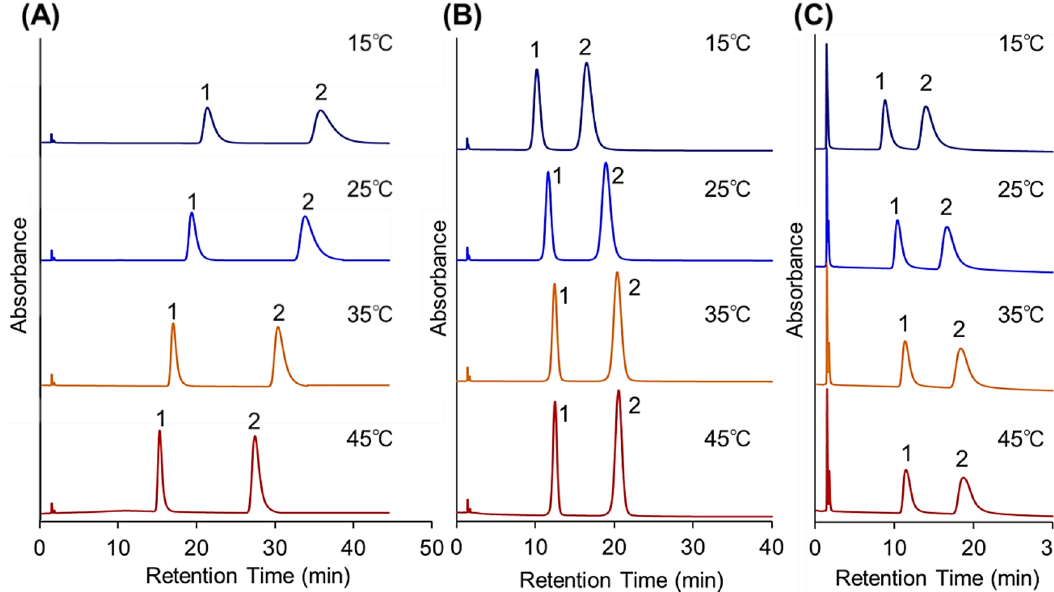
Figure 4. Chromatograms of benzodiazepines using P(NIPAAm- co -BMA) hydrogel-modified bead columns with ( A ) 7-nm pore-diameter beads, ( B ) 12-nm pore-diameter beads, and ( C ) 30-nm pore-diameter beads as